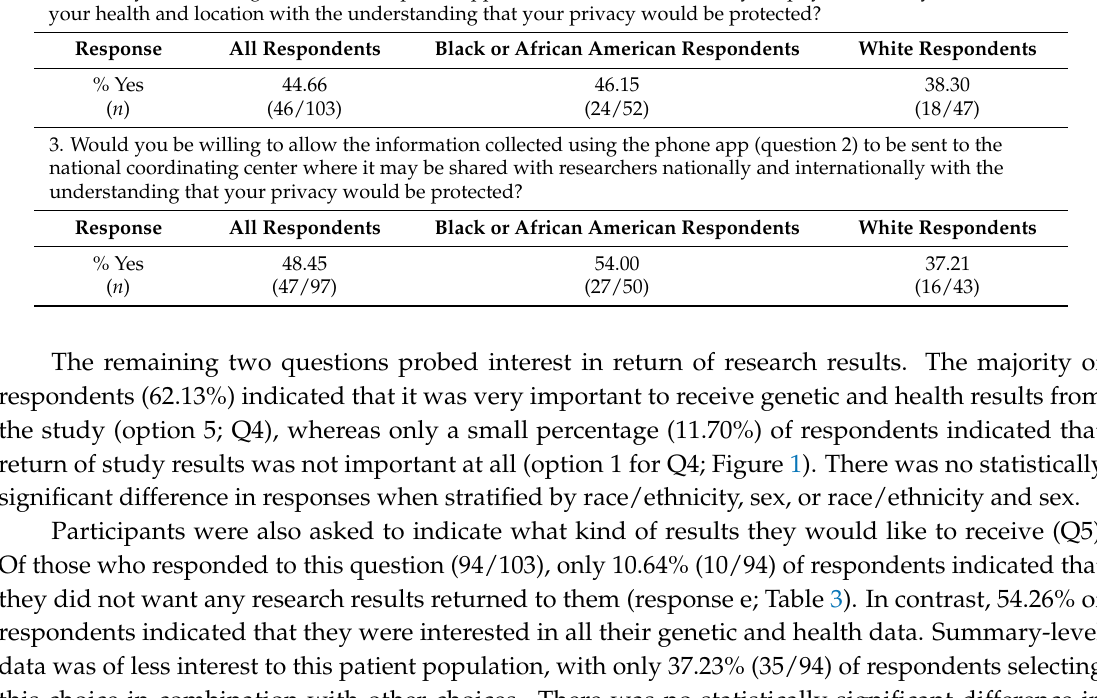
Table 3. Survey question assessing preference in return of research results. Of the 103